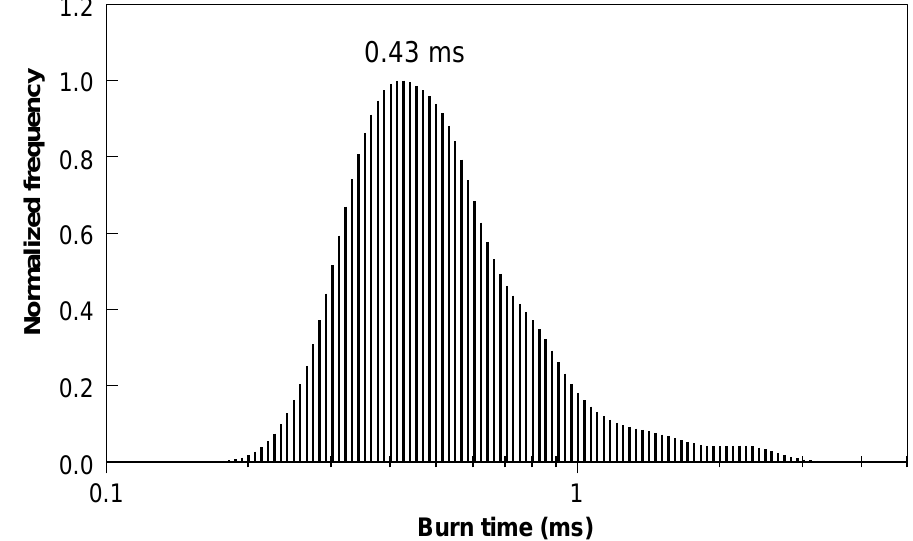
Figure 13. The burn time distribution for particles of 50Si · 50BiF 3 burning in air. The size distribution of the aerosolized 50Si · 50BiF 3 particles passed through the feeder is shown in Figure 14. The distribution was nearly symmetrical, with a mode of 3.09 µm.